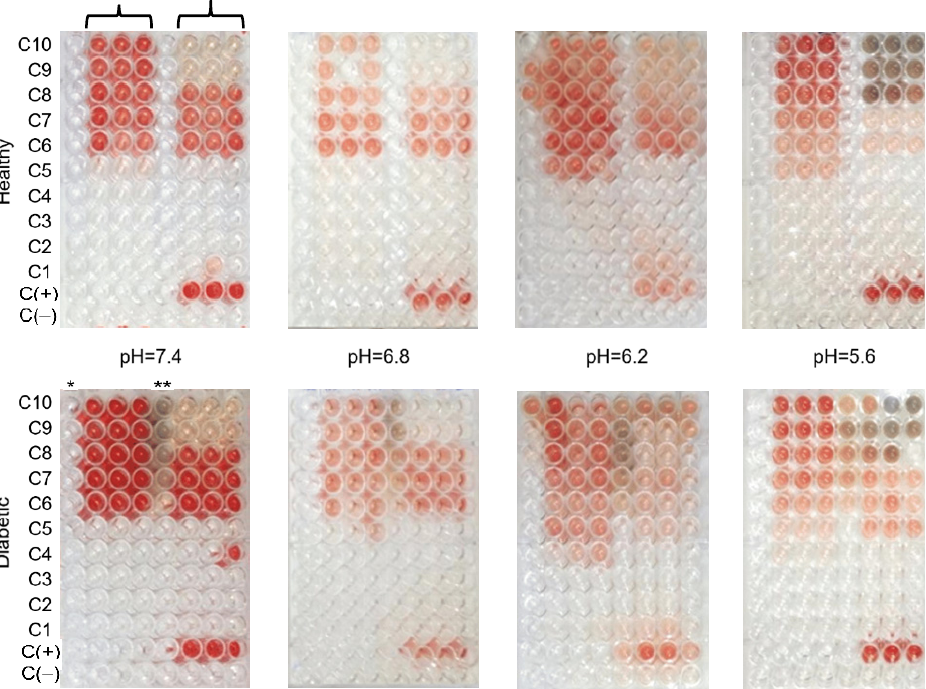
Figure 1. Hemolysis induced by AgNPs and AgNO 3 at different pH for HDE and DDE: AgNPs correspond to blue lines and AgNO 3 to black lines.